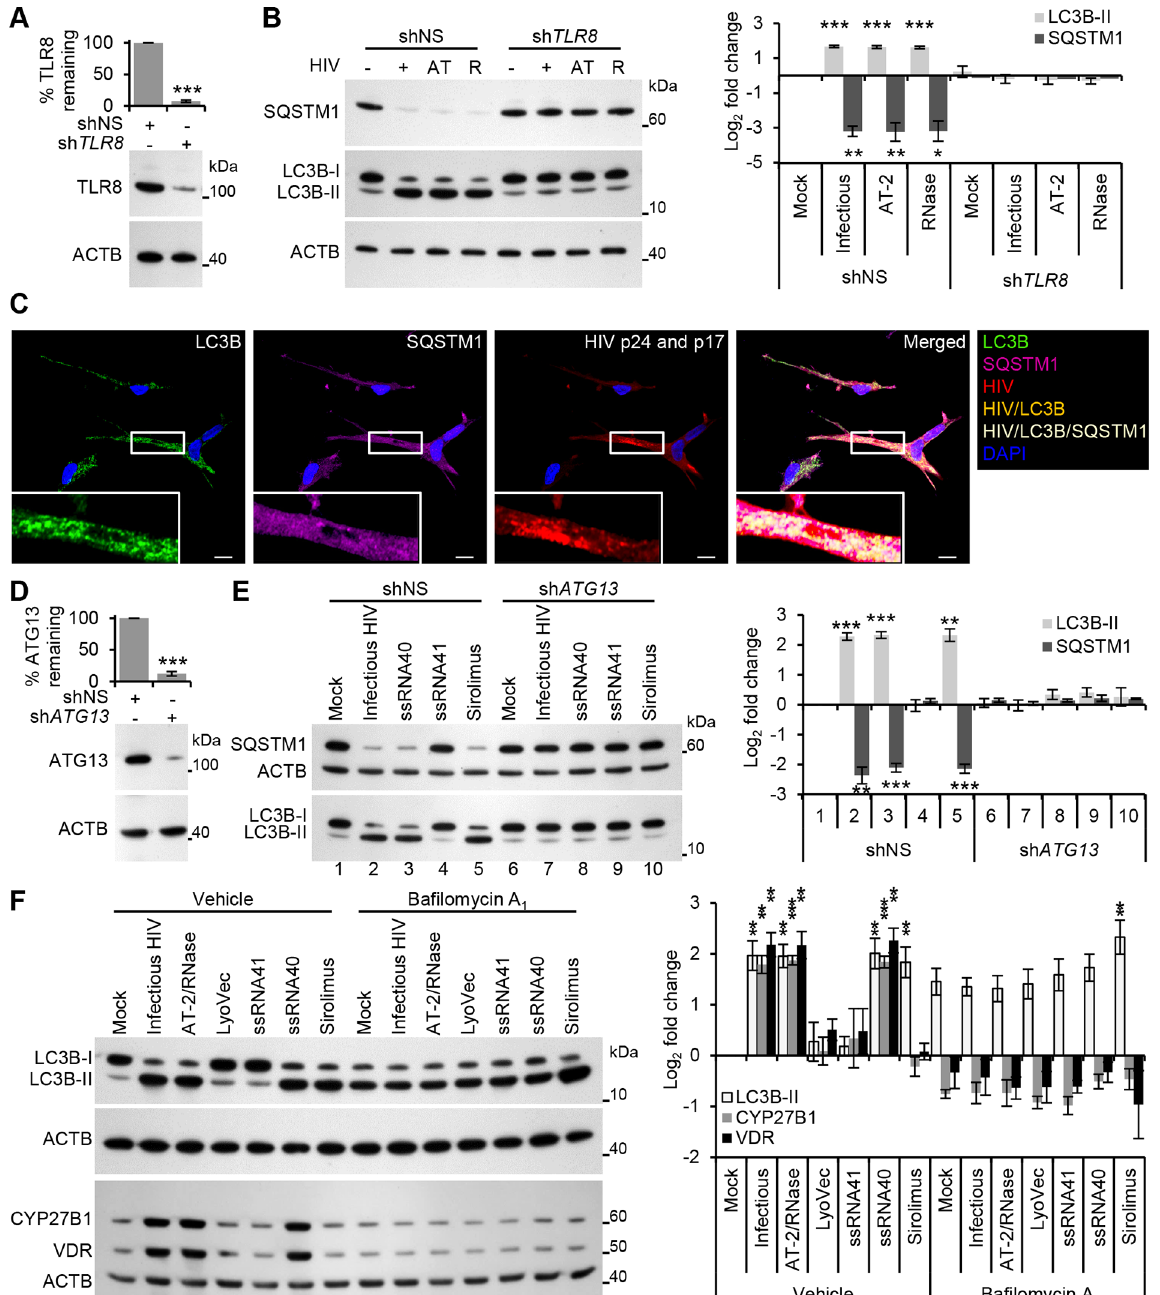
Fig 2. HIV induces autophagy in human macrophages through TLR8. (A) Macrophages were transduced with non-specific scrambled shRNA (shNS), or TLR8 shRNA (sh TLR8 ) and analyzed for TLR8 expression. Bottom , a representative blot is shown. Top , densitometric analysis of immunoblots from independent donors presented as means ± s.e.m., n = 4. (B) Macrophages transduced with shNS or sh TLR8 from (A) were exposed to infectious HIV (+), AT- 2-inactivated HIV (AT), or RNase/DNase I treated AT-2-inactivated HIV (R) or mock infected (-) for 24 h, harvested, lysed and analyzed for endogenous LC3B and SQSTM1 by Western blotting. Left , a representative blot is shown. Right , densitometric analysis of immunoblots from independent donors presented as means ± s.e.m., n = 4. (C) Representative fluorescence microscopy images of HIV-infected macrophages which were fixed, permeabilized then stained with 4',6-diamidino-2-phenylindole (DAPI; blue ) and antibody to LC3B ( green ), SQSTM1 ( magenta ), HIV p24 and p17 ( red ). Co-localization of HIV and LC3B is represented by orange pixels, and co-localization of HIV, SQSTM1, and LC3B is represented by cream pixels. Scale bars indicate 10 μ m. (D) Macrophages were transduced with shNS or ATG13 shRNA (sh ATG13 ) and analyzed for ATG13 expression. Bottom , a representative blot is shown. Top , densitometric analysis of immunoblots from independent donors presented as means ± s.e.m., n = 4. (E) Macrophages transduced with shNS or sh ATG13 from (D) were exposed to infectious HIV, 5 μ g/mL ssRNA40, 5 μ g/mL ssRNA41, or 100 nmol/L sirolimus for 24 h, harvested, lysed and analyzed for